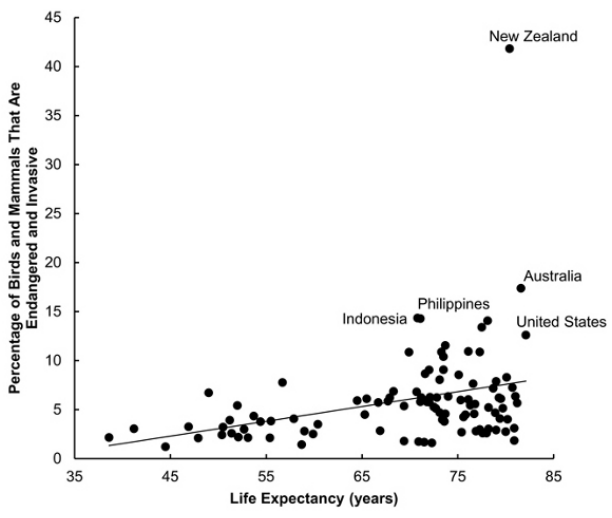
Table 8 . Parameter estimates for variables selected in the best model of social-ecological factors and the proportion of invasive mammals in 100 different countries.